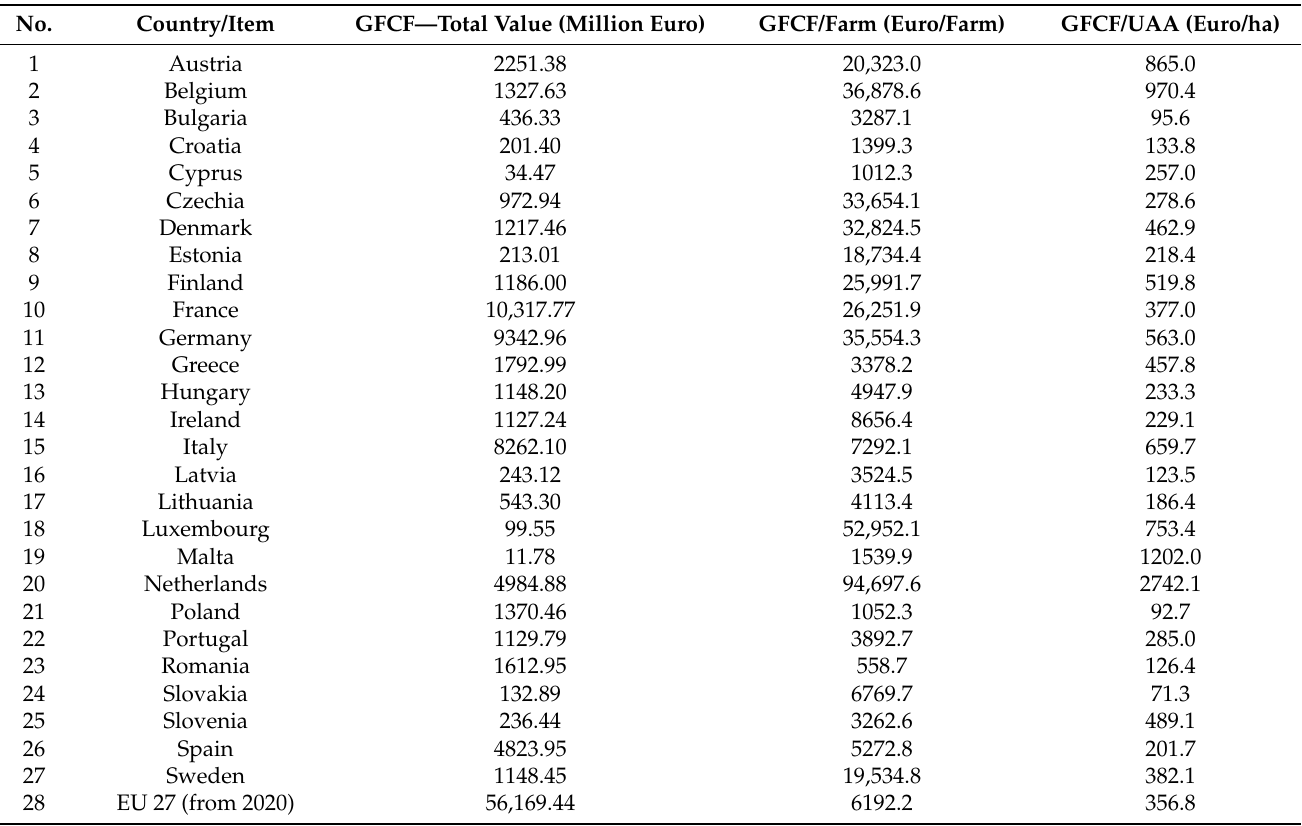
Table 4. Gross fixed capital formation per farm and per hectare of UAA-EU,